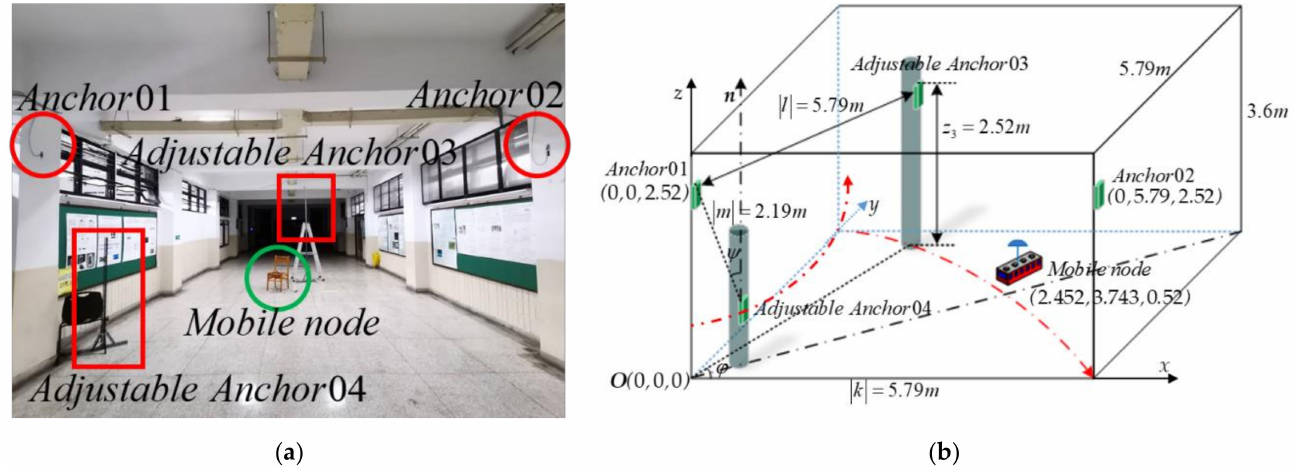
Figure 12. Experiment of measuring mobile node’s positioning errors. ( a ) Photograph showing the positions of the four anchors and the mobile node for the LOS condition; ( b ) Illustration of the experimental environment and the moving trajectory of the adjustable